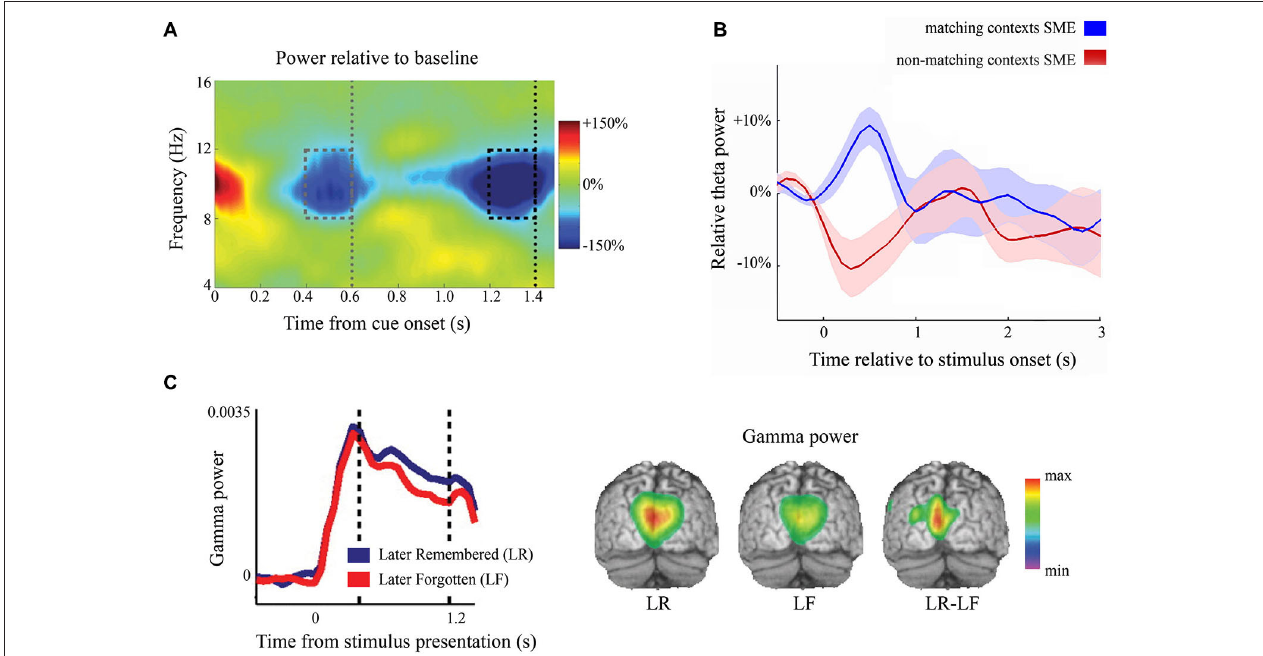
found for successful versus unsuccessful remembering. SME = subsequent memory effect. Reproduced with permission from Hanslmayr and Staudigl (2014). (C) During visual stimulus encoding, posterior gamma power (60–90 Hz) is predictive of subsequent memory performance in young, healthy adults. The vertical dashed bars indicate the window for significance testing and beamformer application. The left panel shows gamma power from one significant posterior sensor and the right panel is the beamformer projection (Osipova et al.,